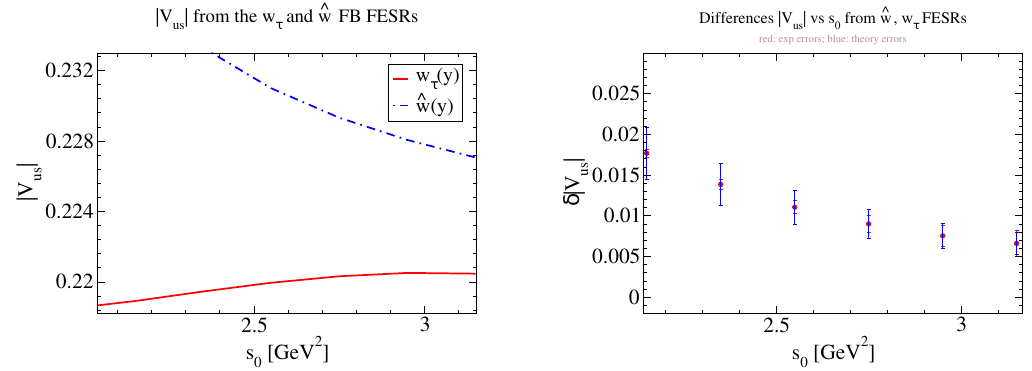
| versus s with conventional implementation D = 6 and 8 us 0